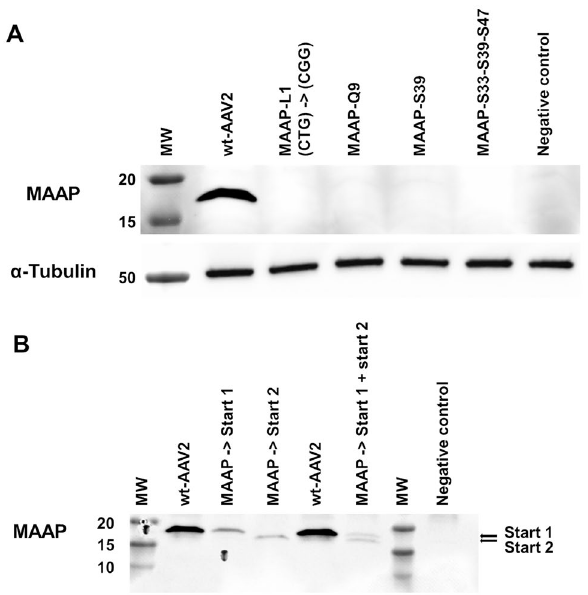
Figure 2. MAAP start codon identification and MAAP inactivation. ( A ) MAAP detected by immunoblot from 293 T cell lysates 24 hpt with wt- or MAAP mutants and Ad helper plasmids. Immunoblots of MAAP (top panel) and of α-Tubulin (lower panel) for equal sample loading. Left to right: (1) MW. (2) wt-AAV2. (3) AAV2 with MAAP-L1 (CTG) start codon modified to R1 (CGG). (4) MAAP-Q9. (5) MAAP-S39. (6) MAAP- S33-S39-S47. (7) non-transfected 293 T cells. ( B ) Start codon usage for MAAP translation. MAAP expressed from the first or second potential start codon and detected by immunoblot. Left to right: (1) MW. (2) wt-AAV2. (3) MAAP expressed from L1 (CTG) mutated to M (ATG). (4) MAAP expressed from R13 (AGG) mutated to M (ATG). (5) wt-AAV2. (6) v/v mix of MAAP expressed from L1 (CTG) mutated to M (ATG) and MAAP expressed from R13 (AGG) mutated to M (ATG). (7) MW. (8) non-transfected 293 T